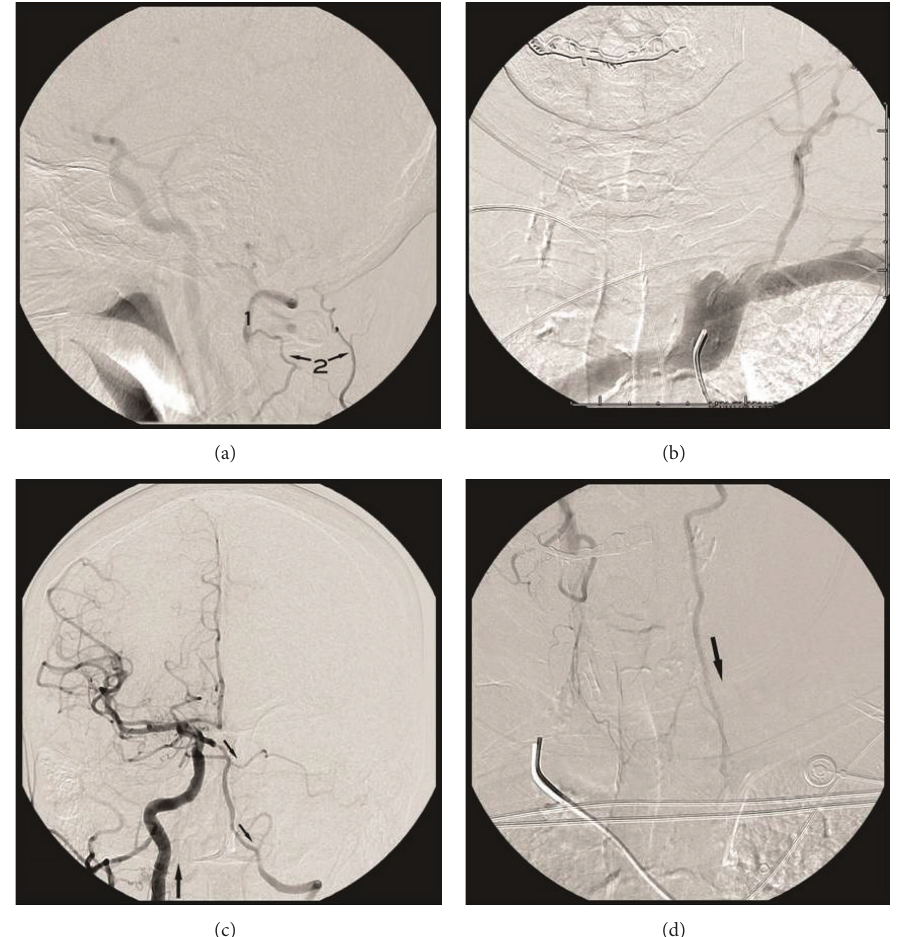
Figure 1: (a) Lateral right subclavian artery angiogram (cranial view) demonstrating occlusion of the right VA with distal reconstitution (1) through muscular branches of the right ascending cervical artery (2). (b) Left subclavian artery angiogram demonstrating normal subclavian artery caliber and a stump at the left vertebral origin with no antegrade VA flow. (c and d) Anteroposterior right common carotid angiogram (cranial and cervical views, resp.) demonstrating flow through the p-comm. artery with retrograde filling of the basilar and left VA down to the level of the subclavian